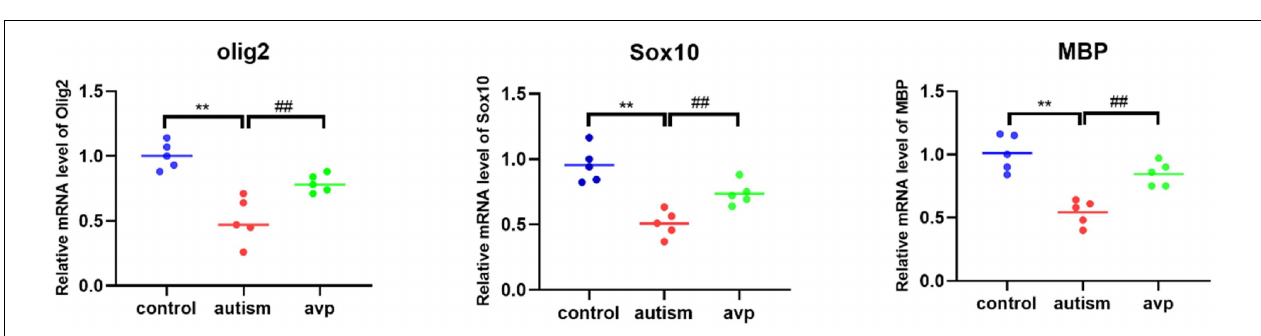
FIGURE 11 | The series of diagrams illustrates the patterns of dynamic changes of gene in each group. Clusters 1 and 8 presented a trend of increasing in the VPA-induced autism model group and decreasing in the AVP group. Clusters 5 and 7 presented a trend of decreasing in the VPA-induced autism model group and increasing in the AVP group. Clusters 2 and 6 presented a trend of gradually declining in the VPA-induced autism model group and AVP group, and clusters 3 and 4 presented a trend of continuous increase in the VPA-induced autism model group and AVP group.